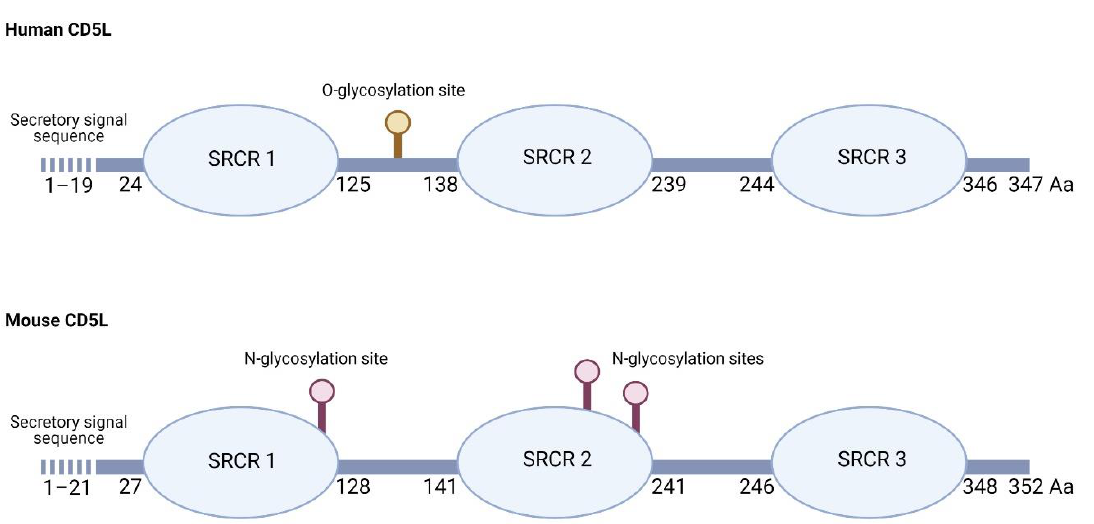
Figure 1. Schematic diagram of human and mouse CD5L. The scavenger receptor cysteine-rich (SRCR) domain structure, secretory signal peptide sequence, O- and N-glycosylation sites, and the amino acid (Aa) number are indicated in each sequence, according to [3–5] and the Uniprot Consortium (figure created with Biorender.com).